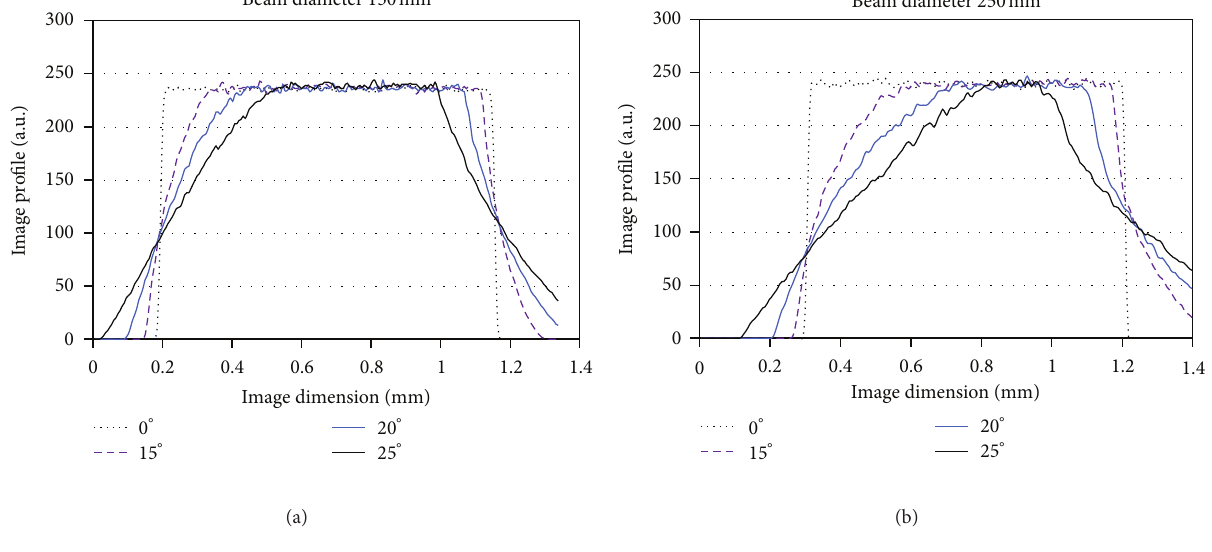
Figure 6: Image profiles for beam diameter 150 mm (a) or 250 mm (b).